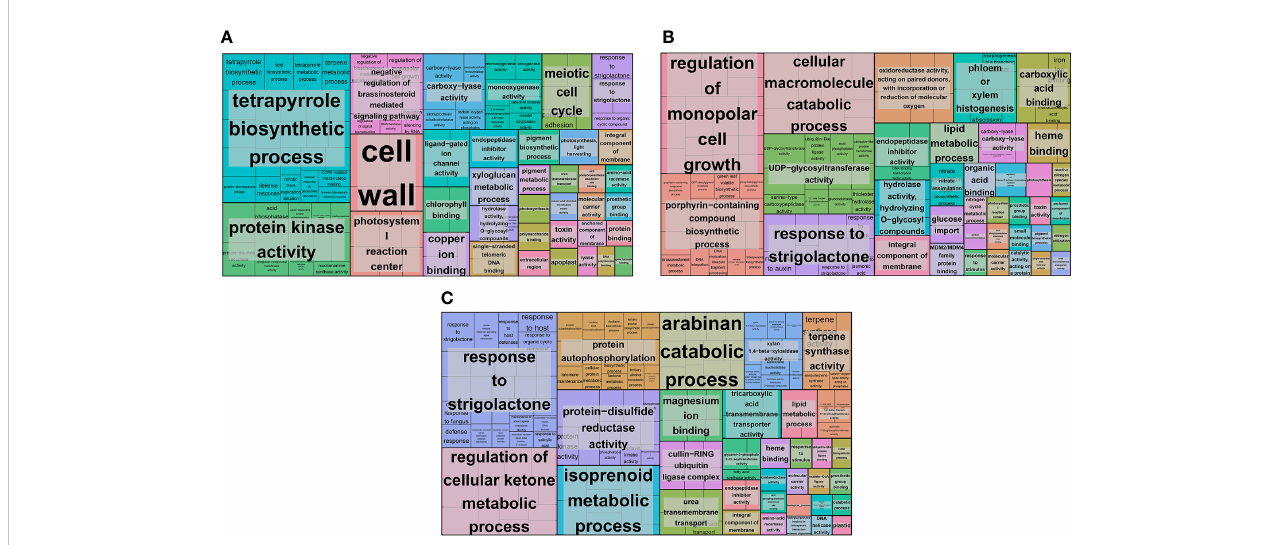
FIGURE 3 The distribution of DEGs and GO functional enrichment analysis. (A) The GO enrichment of CK-vs-N5 comparison; (B) The GO enrichment of CK-vs- N10 comparison. (C) The GO enrichment of CK-vs-N15 comparison. The enriched GO terms were presented in